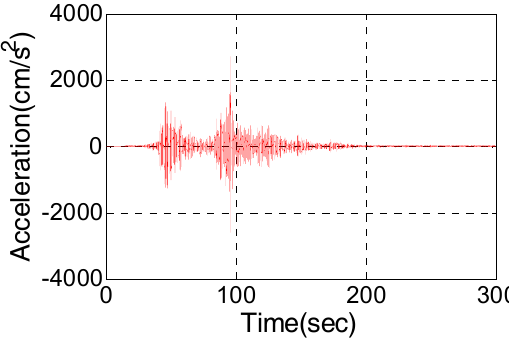
Figure 1. Acceleration sequence from 2011 Honshu earthquake.